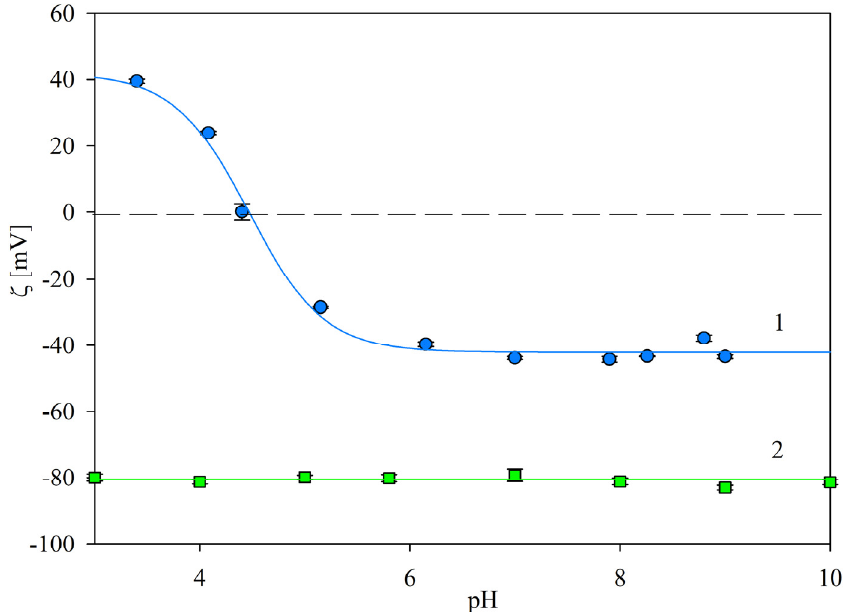
Figure 3. Dependence of the zeta potential of the SAL immunolatex particles on pH, 1 mM NaCl. ( ● ): Experimental results derived from LDV (solid line 1 shows the interpolation of these results). Solid line 2 shows the interpolation of the bare latex results.